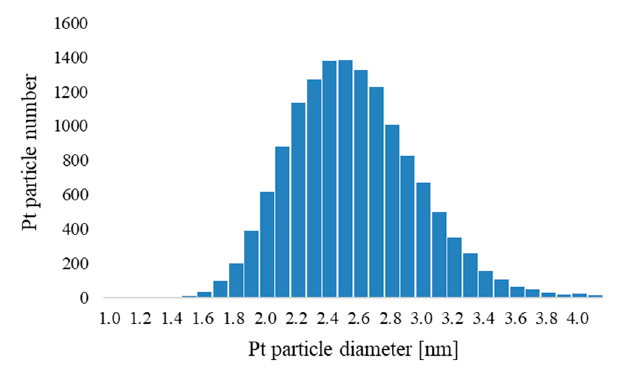
Figure 1. Log-normal platinum particle radius